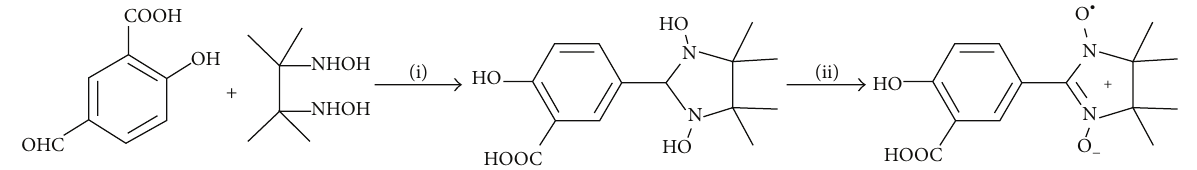
Figure 2: Synthesis of SANR. A scheme showing the synthetic route of SANR. Reagents and conditions: (i) MeOH, r.t.; (ii) NaIO 4 , CH 2 Cl 2 , 0 ∘